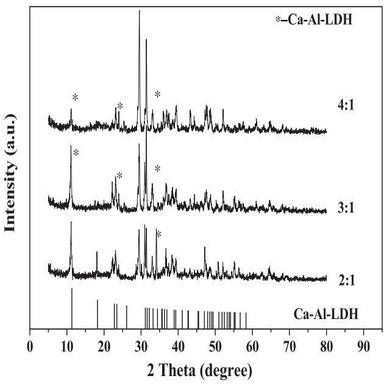
The XRD patterns of products with different mass ratio of AC and Ca (OH)2.